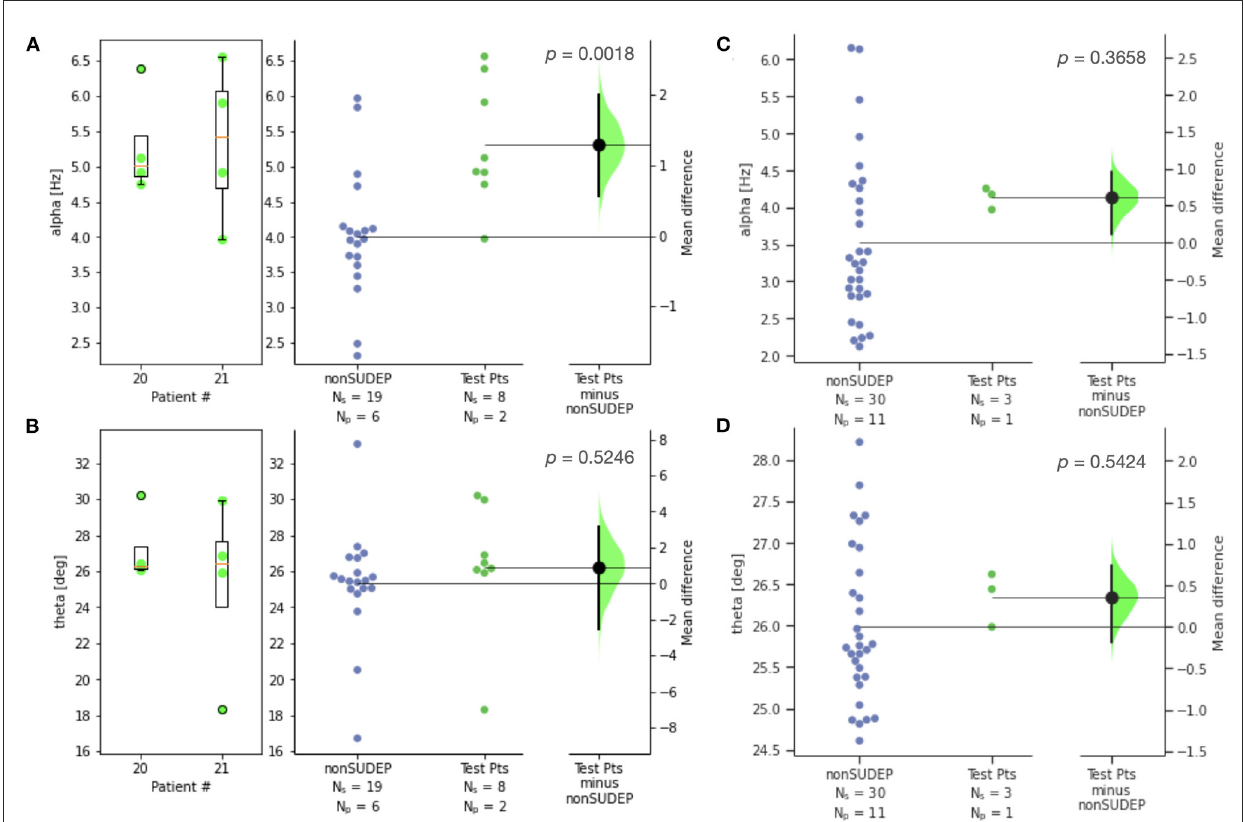
FIGURE4 Estimation statistics for (A) alpha and (B) theta metrics for GTCS of two SUDEP patients reserved for testing, compared to those of non-SUDEP patients; (C) alpha and (D) theta metrics for non-GTCS of SUDEP patient reserved for testing (patient 21), compared to non-SUDEP patients. Patient number is consistent across all figures. N s is number of seizures, N p is number of patients. Blue dots represent seizures from non-SUDEP patients. Green dots represent seizures from SUDEP patients reserved for testing. Pink horizontal bars are mean values by